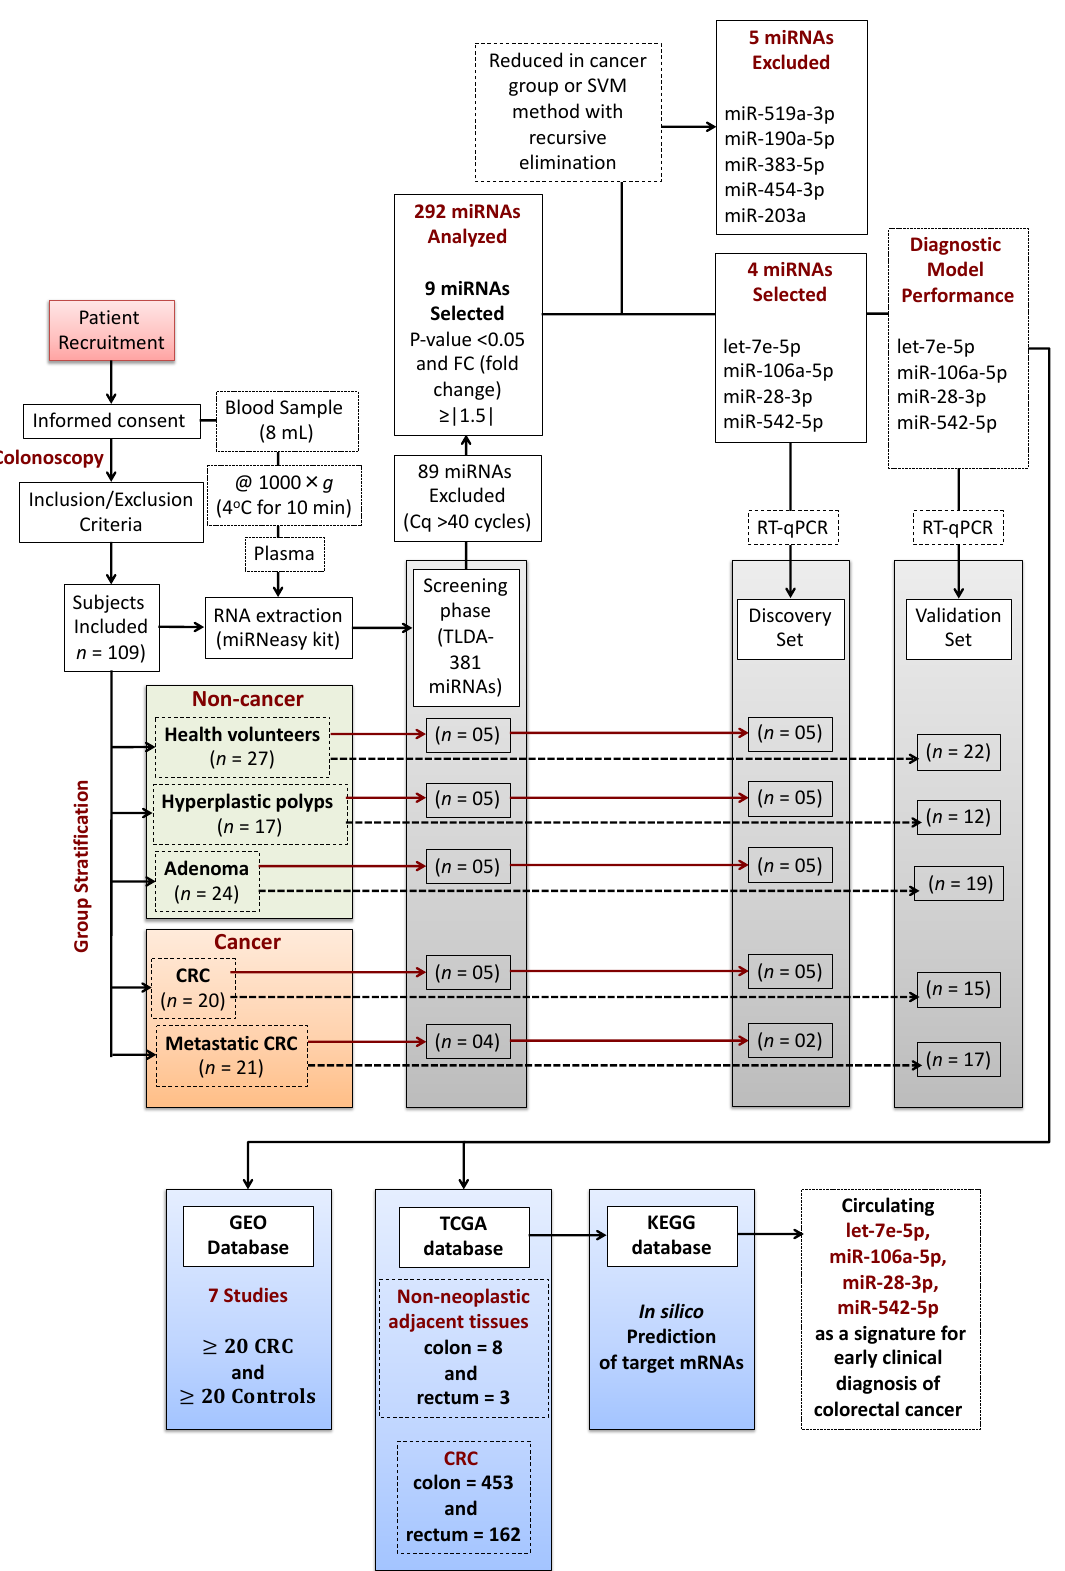
Figure 1. Study workflow to identify a diagnostic miRNA signature from plasma samples of patients at different stages of CRC development. CRC, colorectal